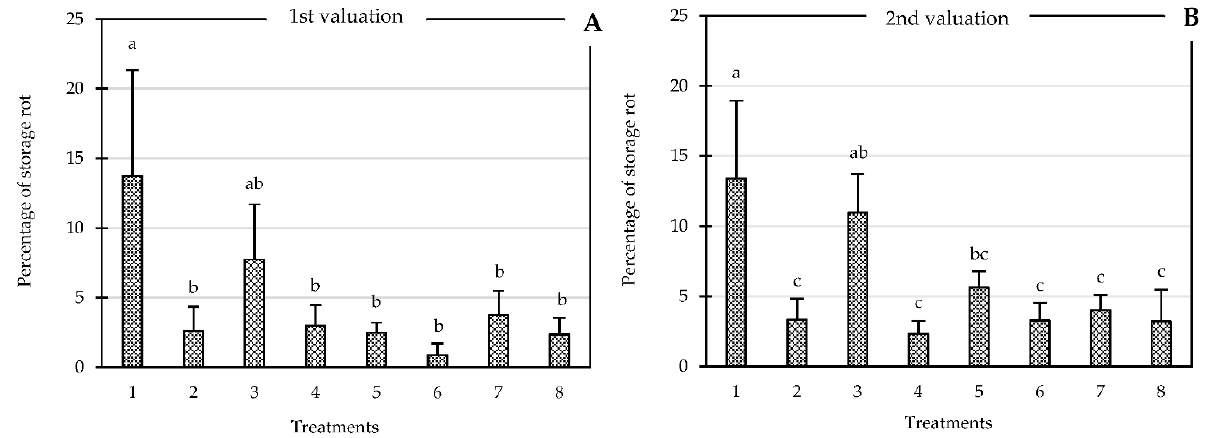
Figure 1. Storage rot percentage as affected by various pre- and post-harvest fungicides after ( A ) 5 months of storage and after ( B ) additional 2 weeks of shelf life. Bars with identical letters do not differ significantly (Tukey Test = 0.05). The standard deviation of the mean is denoted by a capped bar at the top of the column.